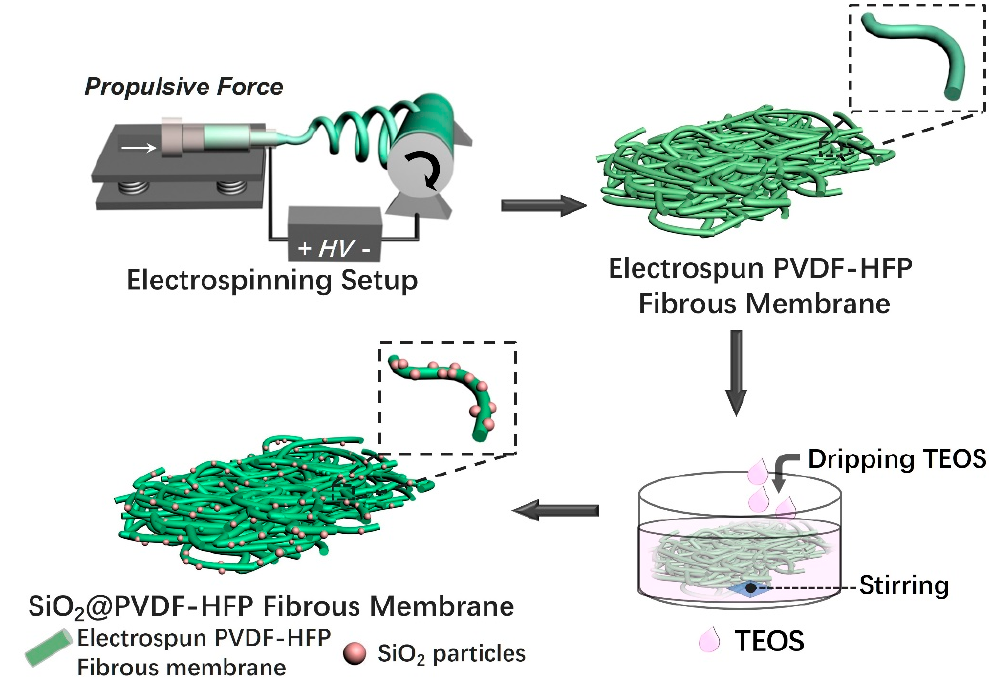
Figure 1. Schematic illustration of multi-structured SiO 2 @PVDF-HFP nanofibrous membrane preparation process. The PVDF-HPF nanofibrous membrane was obtained by electrospinning, and then was immersed in stirred alcohol, TEOS was successively dripped into the alcohol solution. After the minimum time of 6 h, the multi-structured SiO 2 @PVDF-HFP nanofibrous membrane was successfully fabricated.